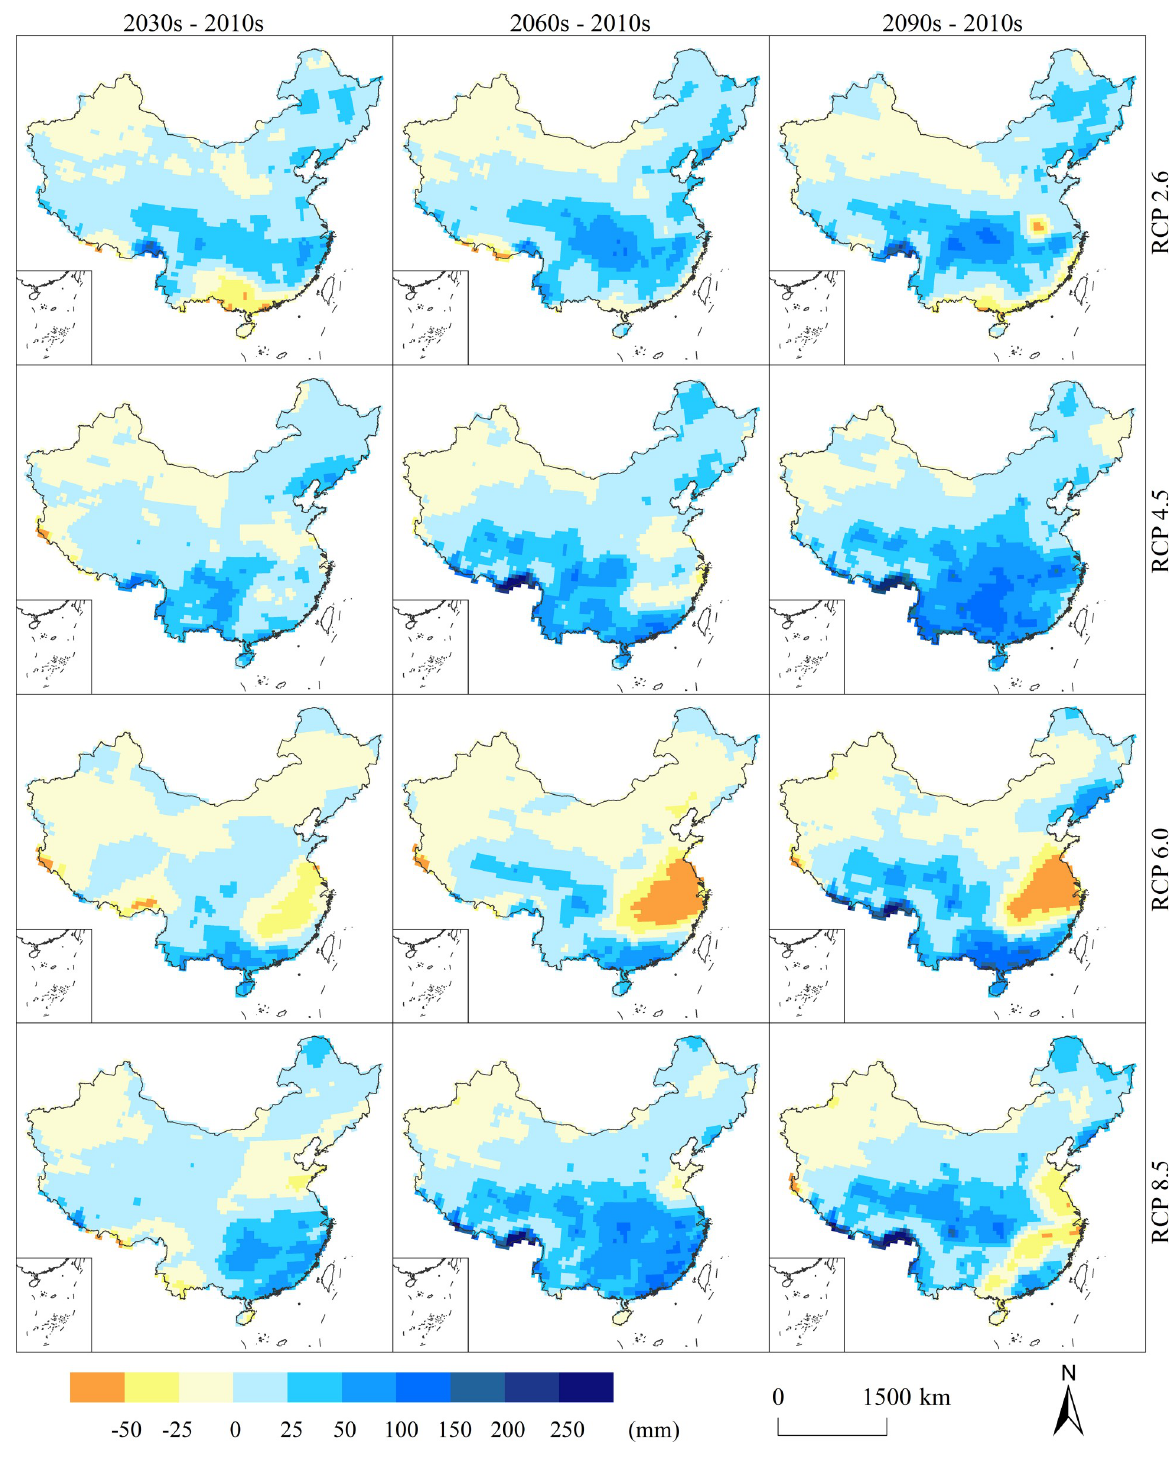
Fig 9. Changes in the average annual available precipitation under RCP scenarios.